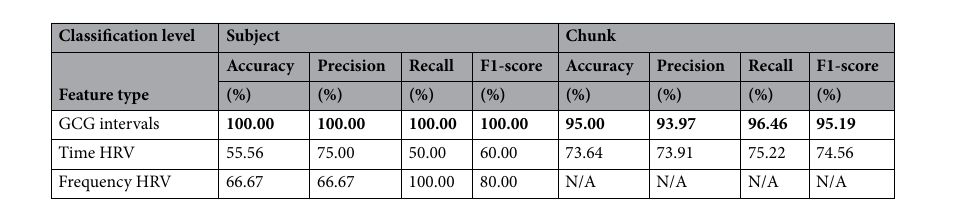
Table 5. Feature ablation evaluation using XGBoost. Significant values are in